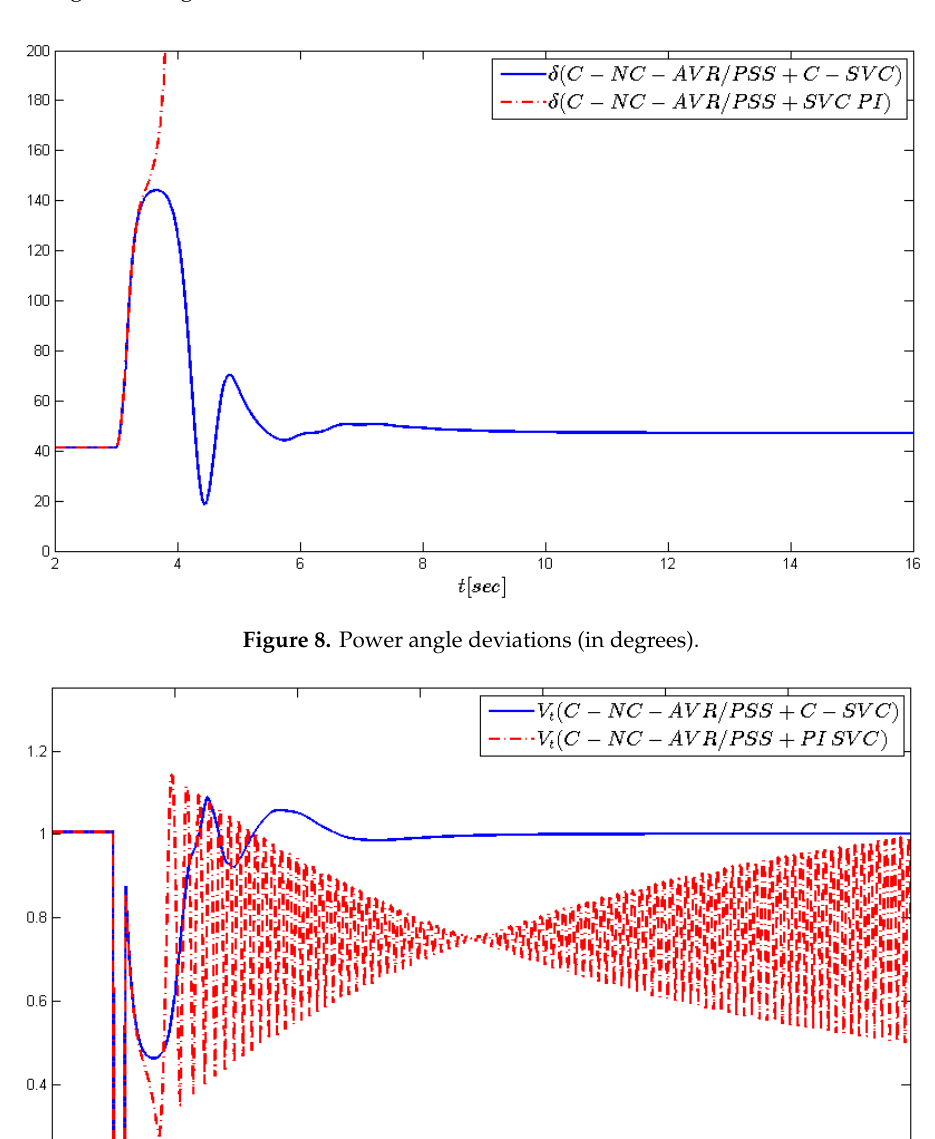
Figure 9. Generator terminal voltage responses (in p.u.).